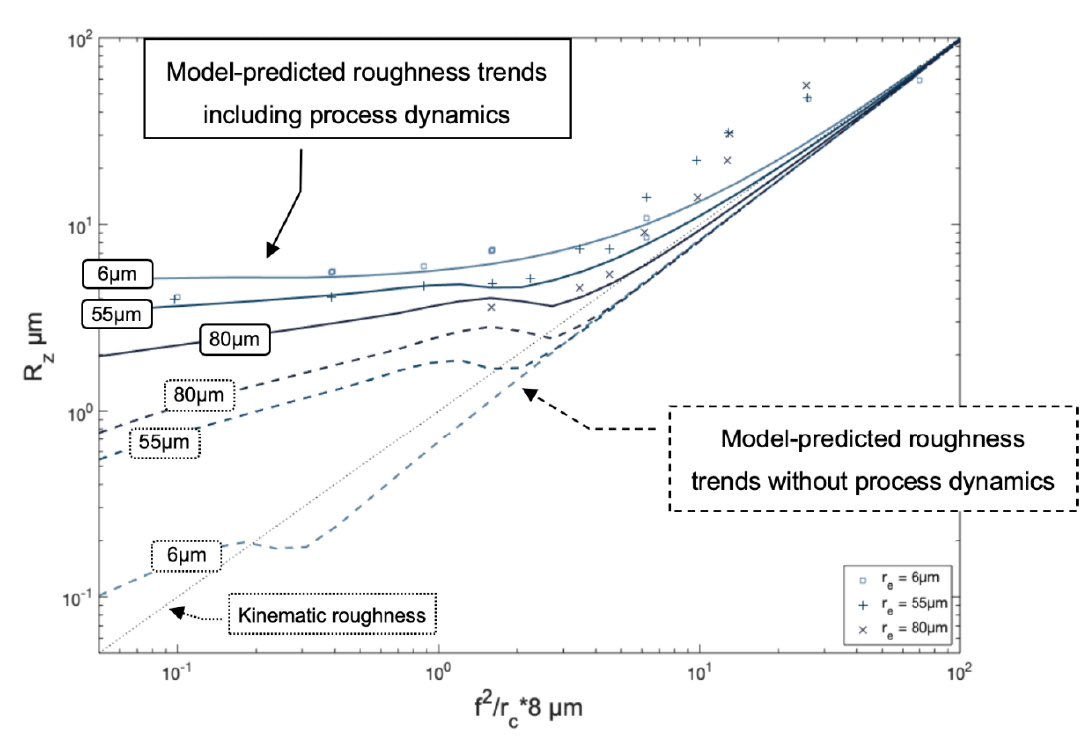
Figure 13. Roughness ( R z ) model (lines) compared to roughness data adapted from Childs et al. [23]. The MTE-affected roughness is shown to be predicted by the adjusted model with some accuracy. Material: Al 1075.